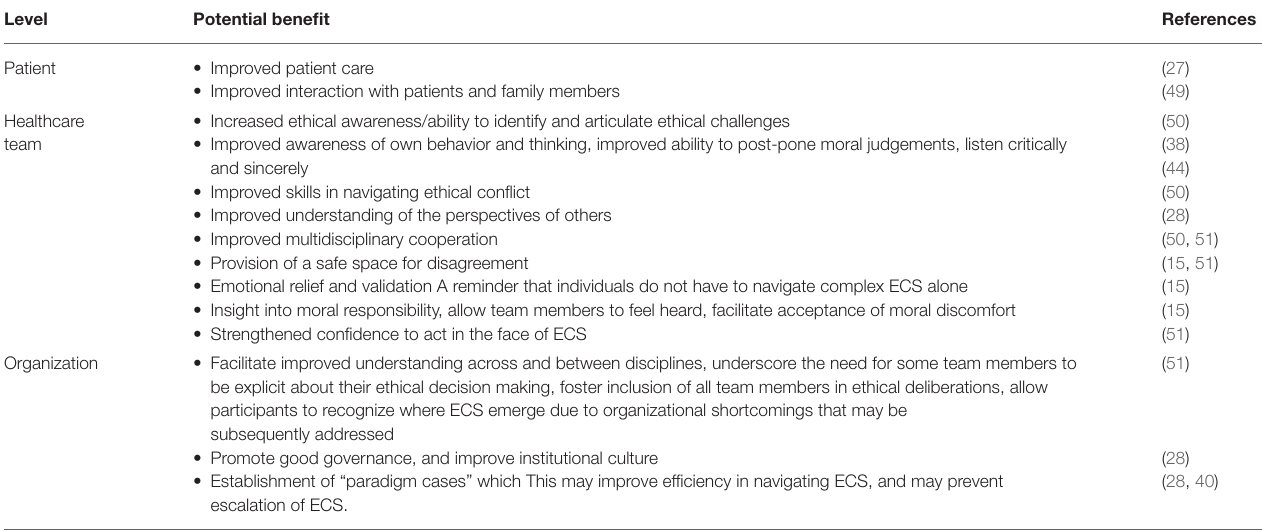
TABLE 1 | Potential benefits of bottom-up clinical ethics support services at the level of the patient, healthcare team and